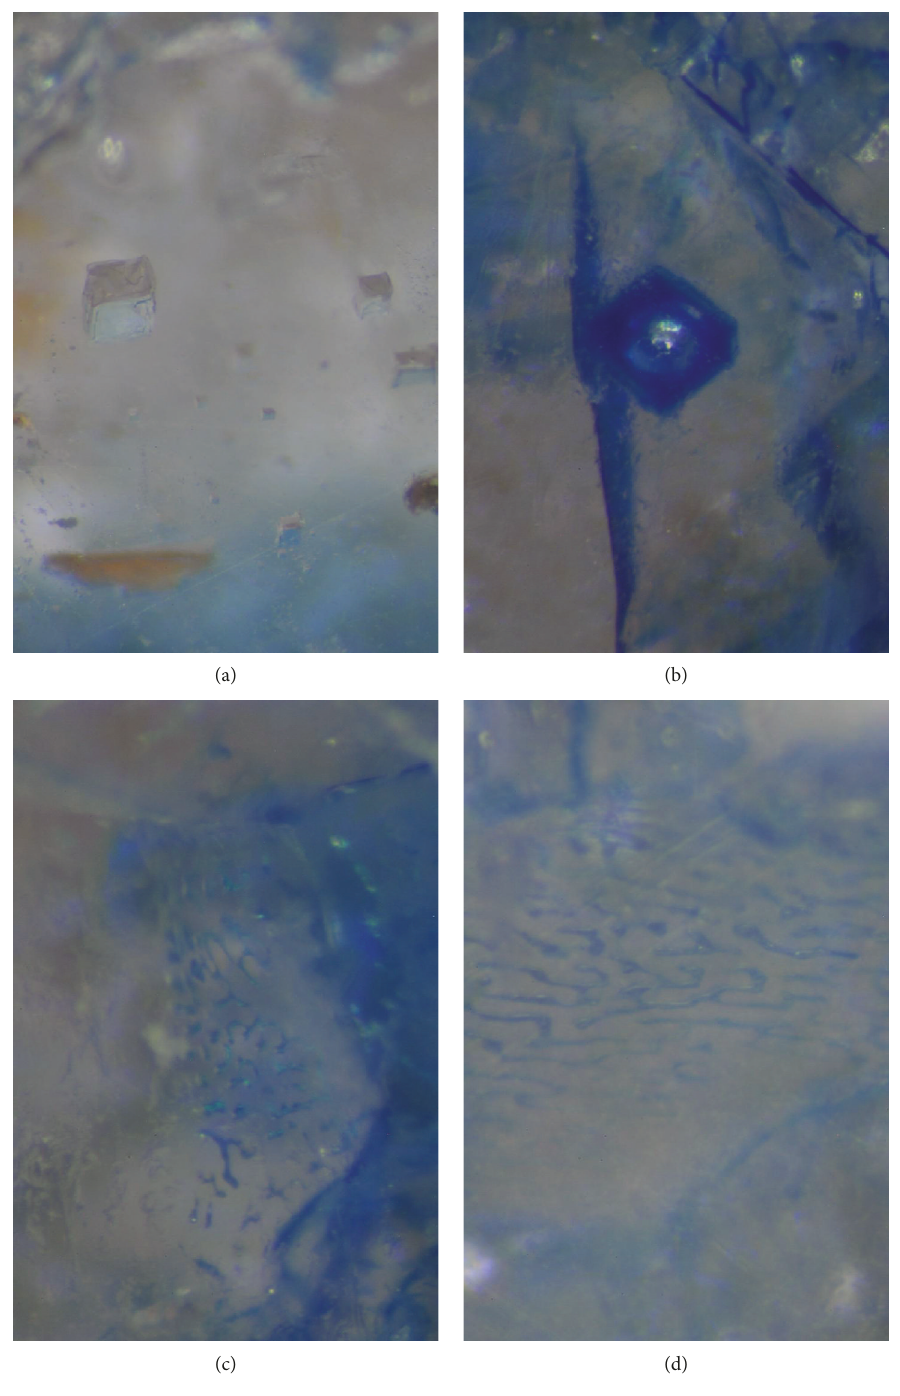
Figure 7: All images are of deformed sample QGU16-3_6.0. (a) Fluid inclusions not intersected by fractures in deformed salt. (b) Intragranular fracture intersecting a fl uid inclusion. (c, d) Intergranular fracture along the grain boundary with blue-stained epoxy- fi lled tubules (re fl ected light, vertical fi eld of view is 2.25mm for each